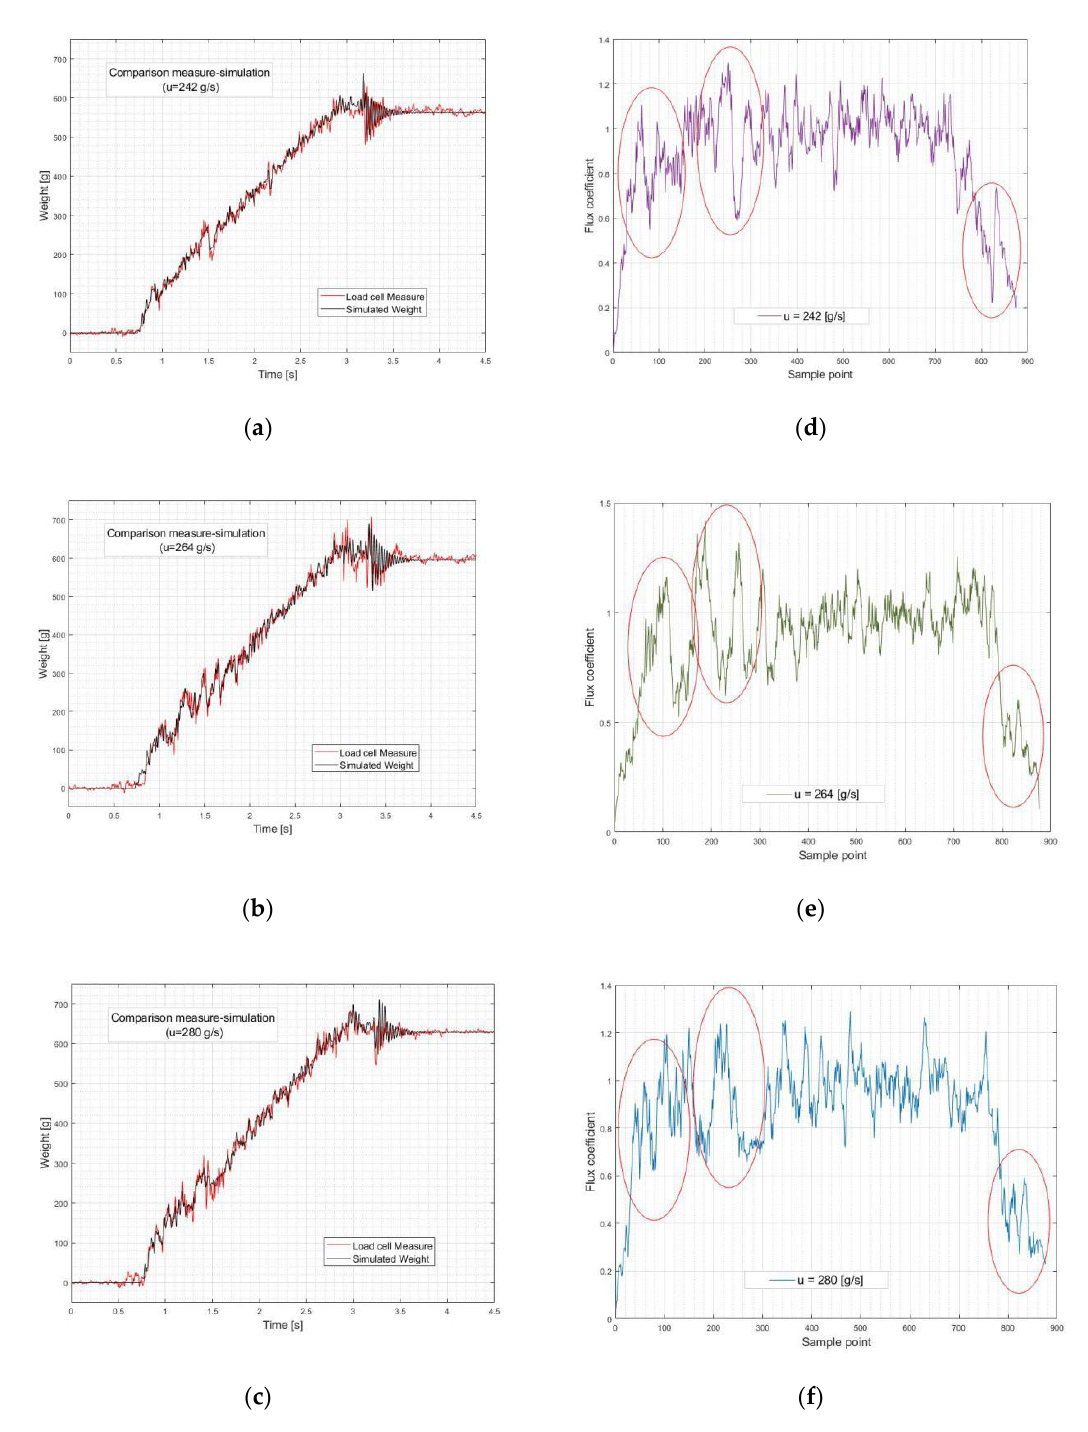
Figure 12. Comparison between the measured (red) and simulated (black) weight with ( a ) u = 242 (g/s), ( b ) u = 242 (g/s), ( c ) u = 242 (g/s); Flux coefficient identified with ( d ) u = 242 (g/s), ( e ) u = 242 (g/s), ( f ) u = 242 (g/s).